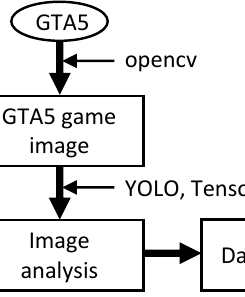
Figure 2. Overall algorithm of the autonomous driving simulation.